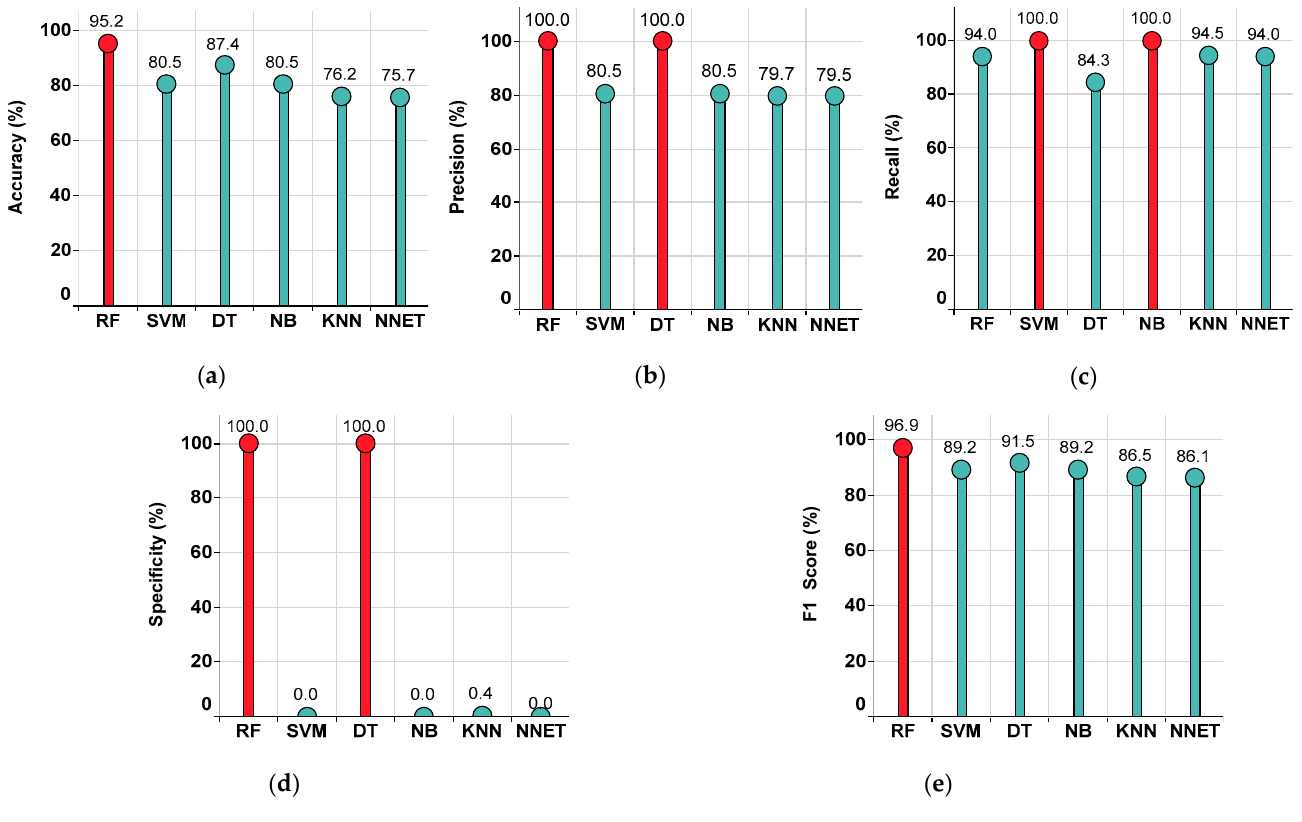
Figure 9. Performance metrics for the single-classifier approach on the bagging imputed dataset. ( a ) Accuracy. ( b ) Precision. ( c ) Recall. ( d ) Specificity. ( e ) F1 Score.